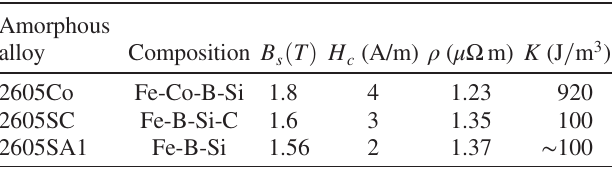
alloys. B s , H c , ρ , and K represent the saturation induction, coercive force, resistivity, and induced anisotropy energy of the material,